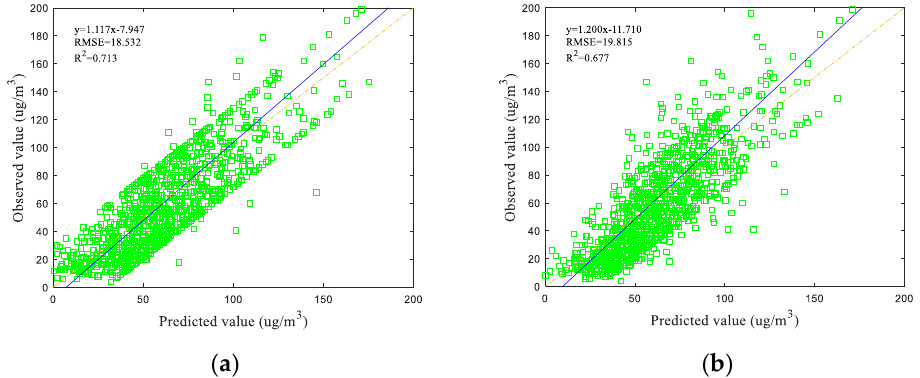
Figure 6. Verification results of the MGWODBN model. ( a ) Fitting of training data. ( b ) 10-fold cross validation.